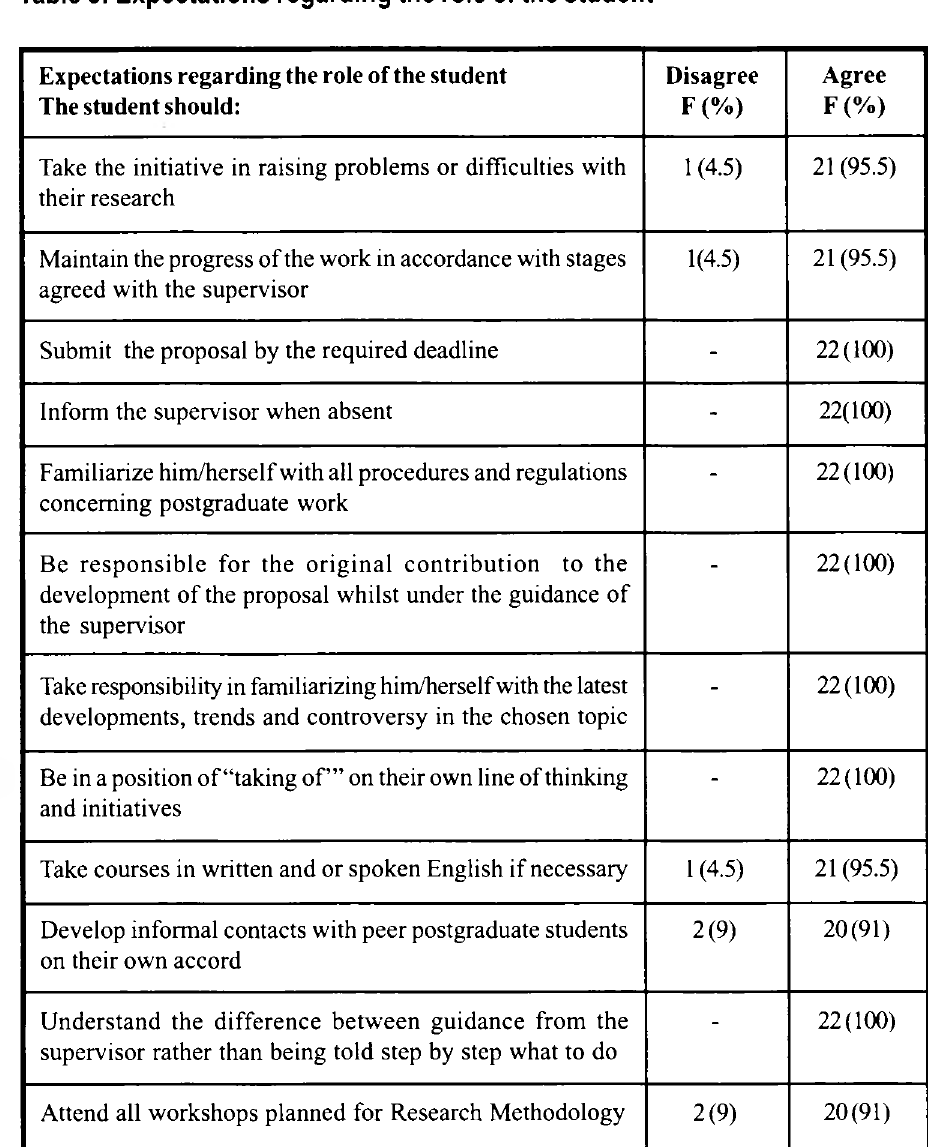
Table 3: Expectations regarding the role of the